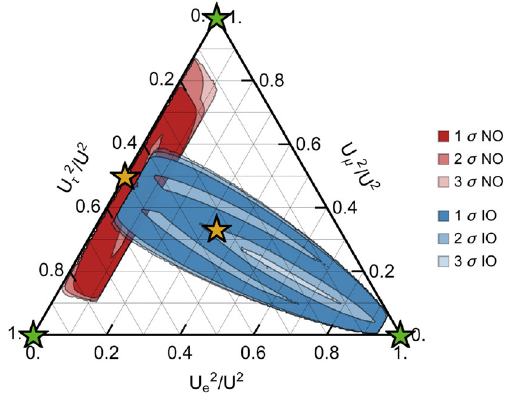
Fig. 1 Thenewbenchmarks(3)andoldbenchmarks(2)for U 2 e : U 2 μ : U 2 τ (here displayed in the form U 2 α / U 2 ) are represented by the yellow and green stars, respectively. They are compared to the range of U 2 α / U 2 consistent with light neutrino oscillation data [23] for normal (red) and inverted (blue) ordering of light neutrino masses in the large mixing limit (4) of the minimal seesaw model A). In this limit these ratios are completely fixed by the light neutrino oscillation parameters, and are in particular independent of M across the entire mass range targeted by direct searches at accelerators